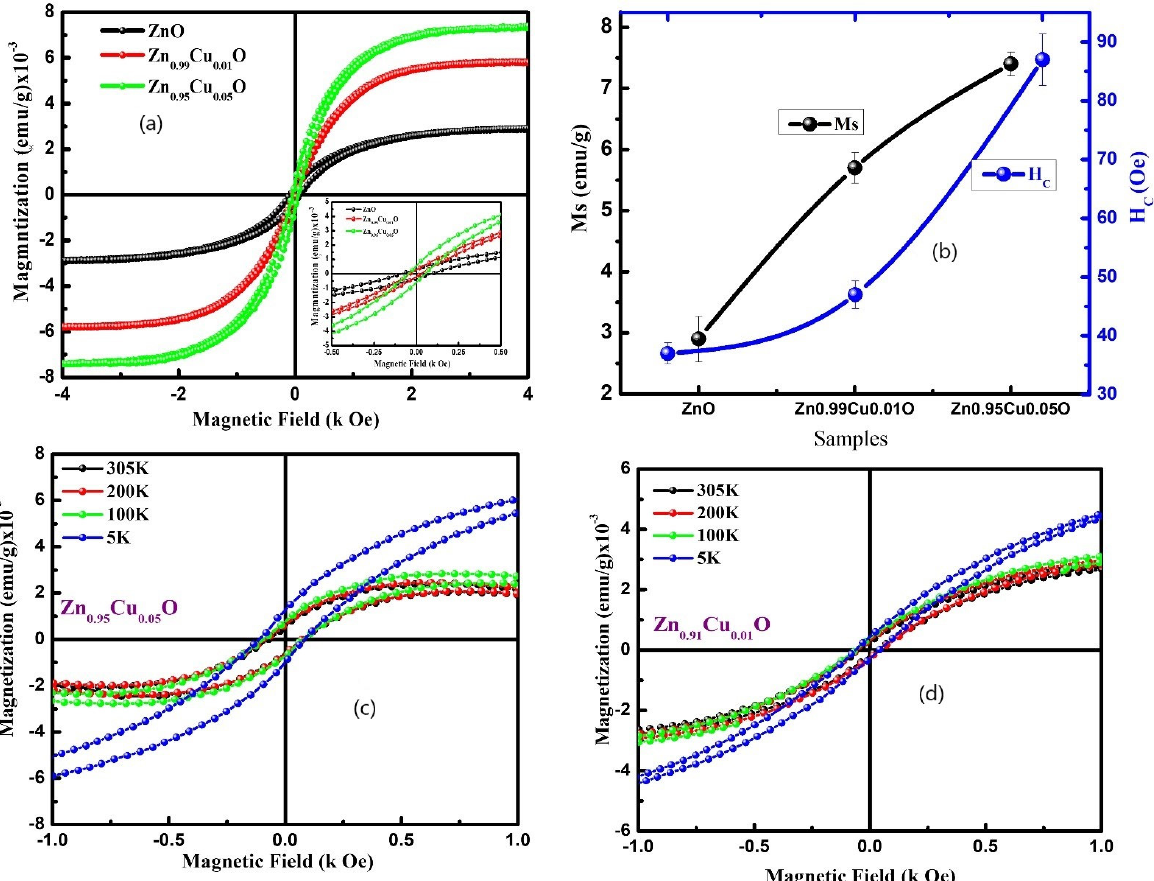
Figure 7. ( a ) M–H loop of Cu-doped ZnO nanostructures. ( b ) Coercive field (H C ) and saturation magnetization (M S ) of Cu-doped ZnO nanostructures. ( c ) Low temperature M–H loop Zn 0.99 Cu 0.01 O nanostructures. ( d ) Low-temperature M–H loop Zn 0.95 Cu 0.05 O nanostructures.